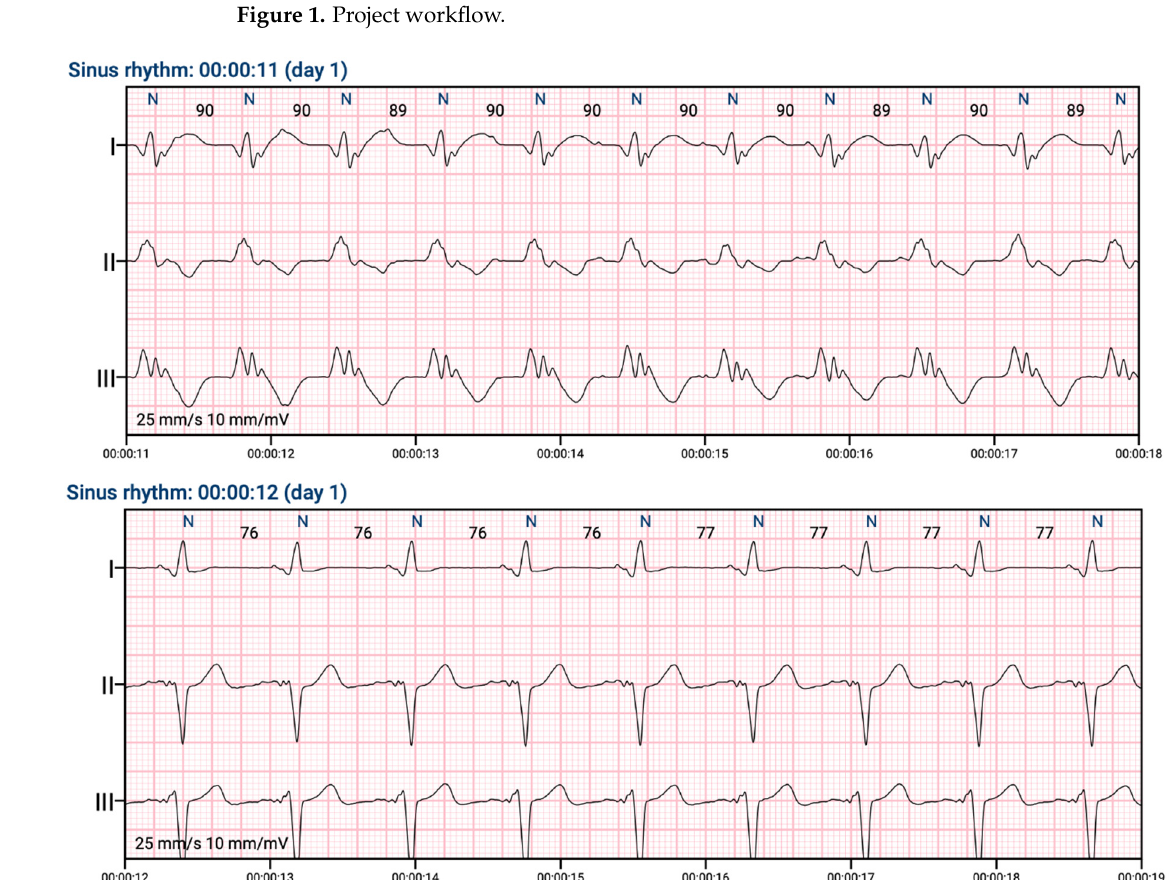
Figure 2. An example of an ECG in the same patient with CRT mode off ( A ) and on ( B ), which was used for AI algorithm training. used for AI algorithm